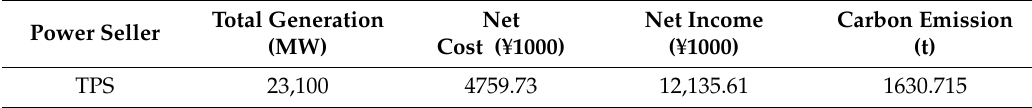
Figure 6. Thermoelectric Units’ Output States in the Reference Scenario. Table 5. Data of the TPS in the reference scenario.